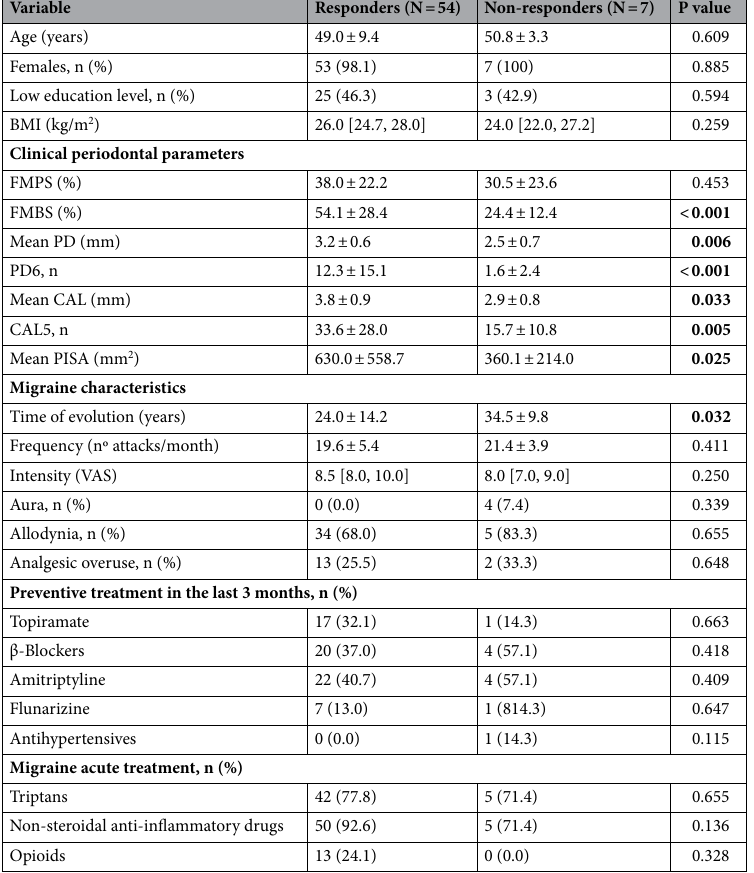
Table 1. Characteristics of chronic migraineurs according to treatment response (N = 61). BMI body mass index, CAL clinical attachment level, CAL5 number of periodontal pockets with CAL ≥ 5 mm, FMBS full-